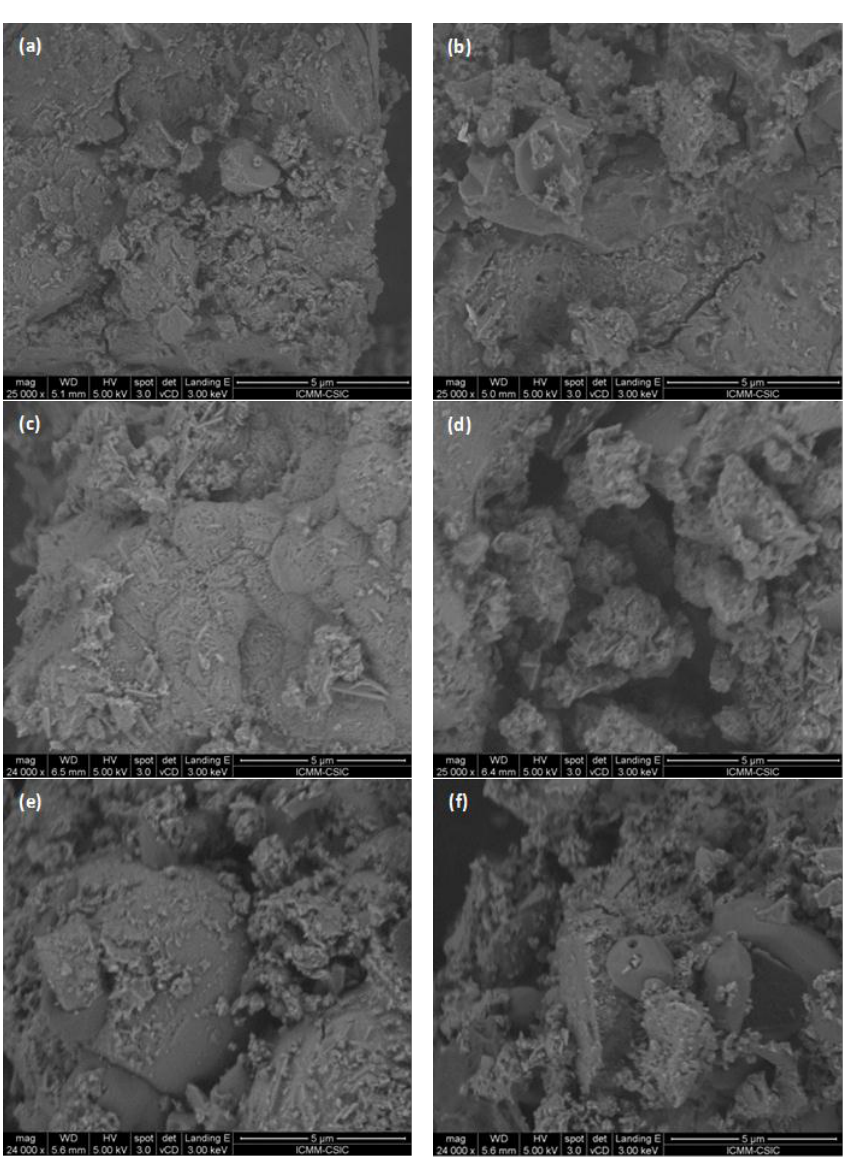
Figure 4. SEM images of the alkali activated mixtures: ( a ) F0S10; ( b ) F10S0; ( c ) F2S8; ( d ) F4S6; ( e ) F6S4; and ( f ) F8S2 at the age of 90 days.